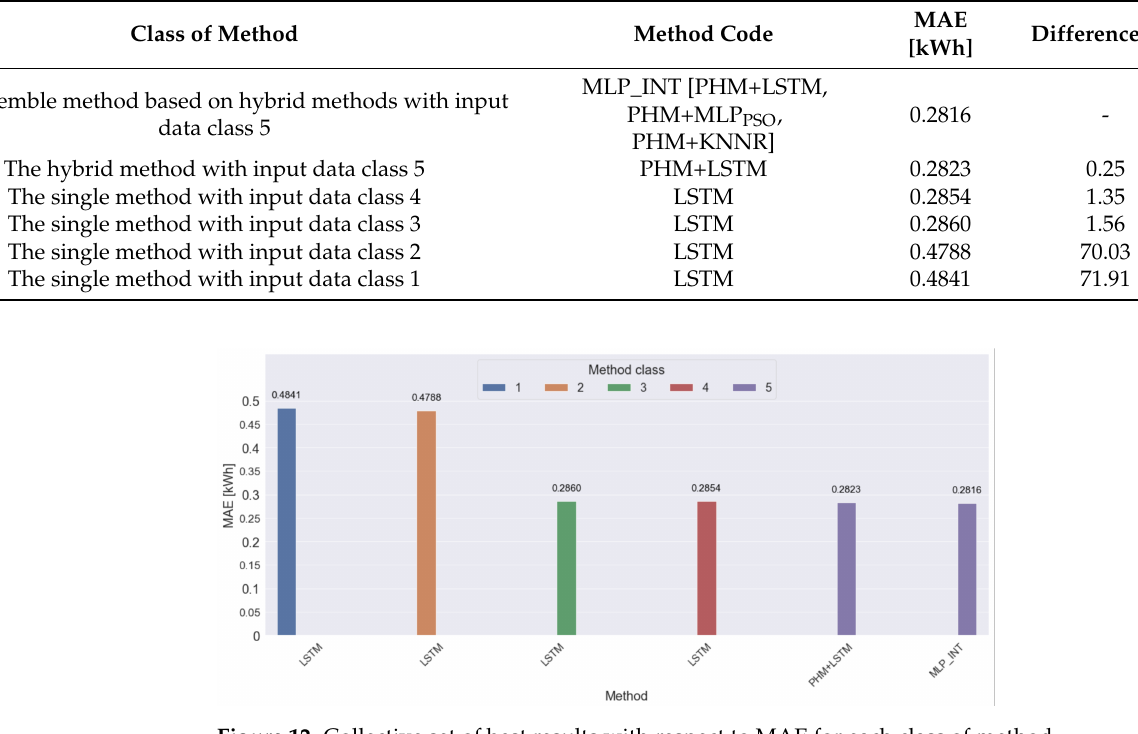
Figure 12. Collective set of best results with respect to MAE for each class of method. Table 14. Collective set of best results with respect to RMSE for each class of method.